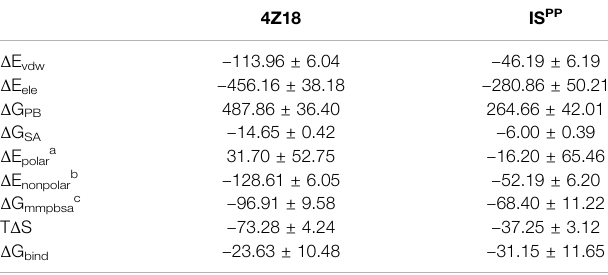
TABLE1| Thebindingfreeenergies(kcal mol − 1 )anditscomponentsforthedimer 4Z18 and IS PP .